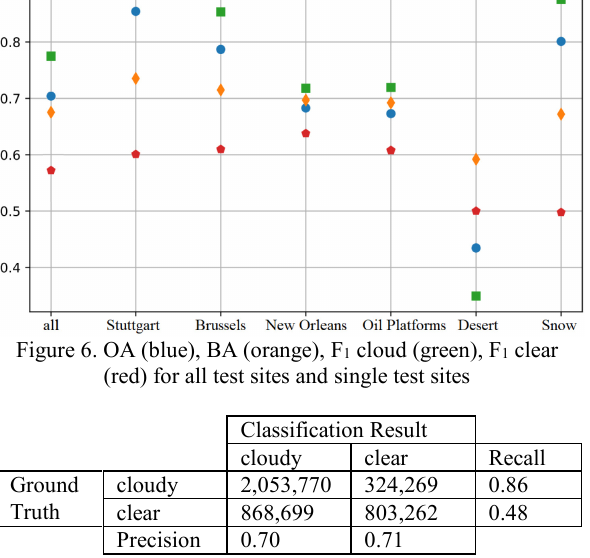
Table 2. Confusion matrix for all test